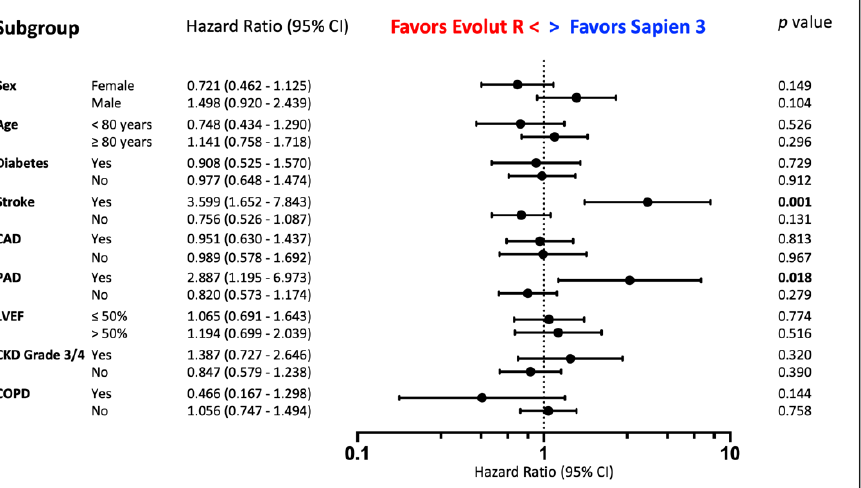
Figure 3. Prosthesis Choice. Subgroup Analysis by Cox Regression according to Prosthesis Choice. Stroke = History of Stroke, CAD = Coronary Artery Disease, PAD = Peripheral Artery Disease, CKD = Chronic Kidney Disease, LVEF = Left Ejection Fraction, COPD = Chronic Pulmonary